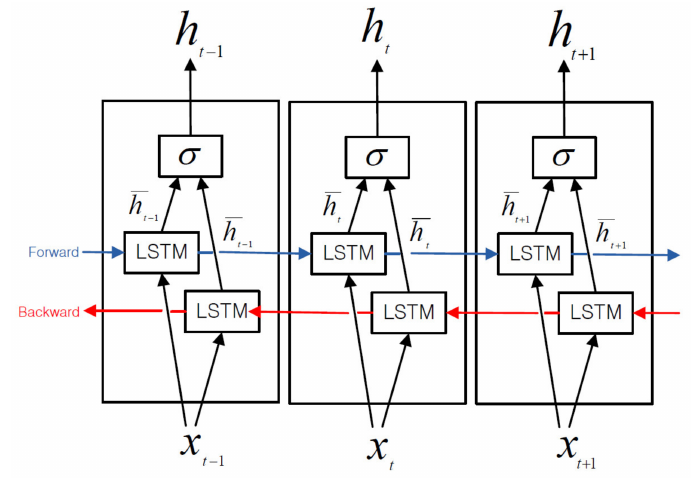
Figure 4. Bidirectional LSTM